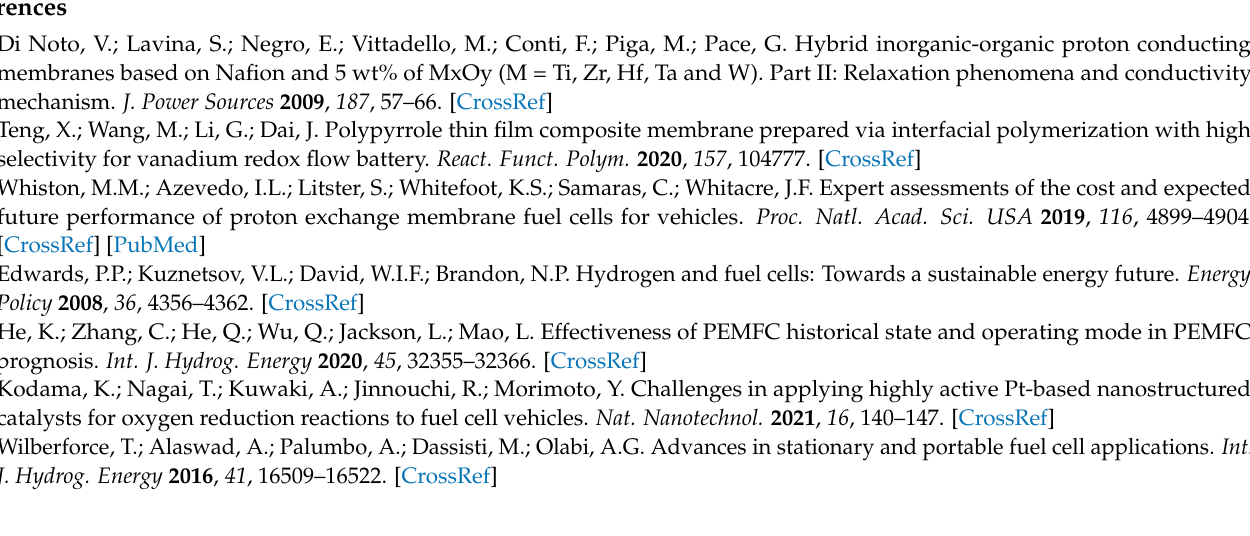
curve, Figure S4: Polarization curve of MEAs, Table S1: High-frequency resistances of the MEAs and relative ionic